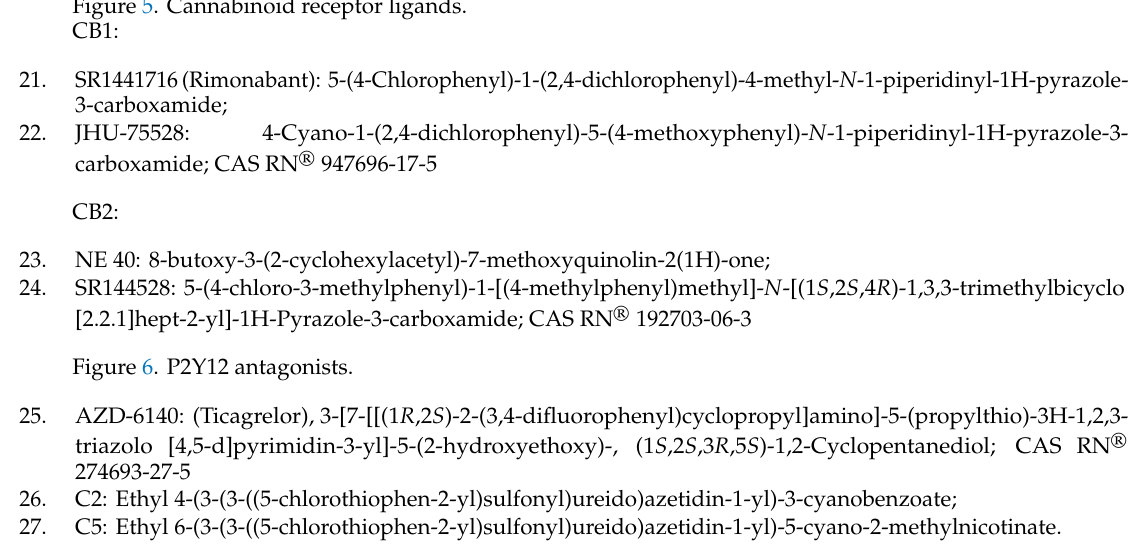
Figure 5. Cannabinoid receptor ligands.